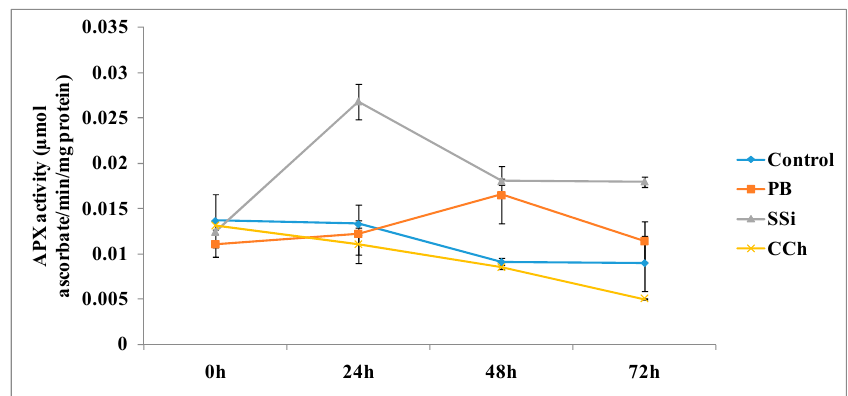
Figure 4. Time course of the APX activity ( μ mol ascorbate/min/mg protein) in extracts from table grape cv. Italia peel treated or not with PB, SSi and CCh. All the values are the means of three replicates ± SE.